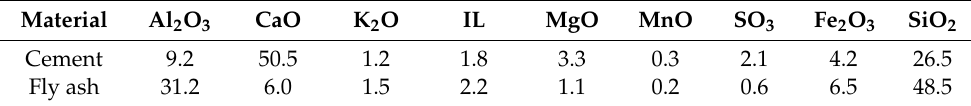
Table 1. Chemical composition of cementitious materials (w/%).